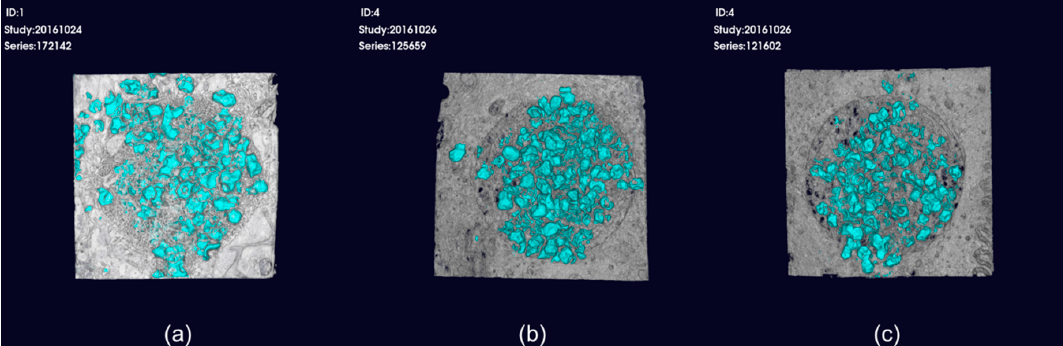
Figure 2. 3D reconstructed micro-computed tomography (micro-CT) images. ( a ) Bone graft with no membrane. The grafted material is dispersed out of the bone defect; ( b ) bone graft with the collagen membrane; ( c ) bone graft with GEL/TSG film. Grafted material is implanted in the bone defect in ( b ) and ( c ).